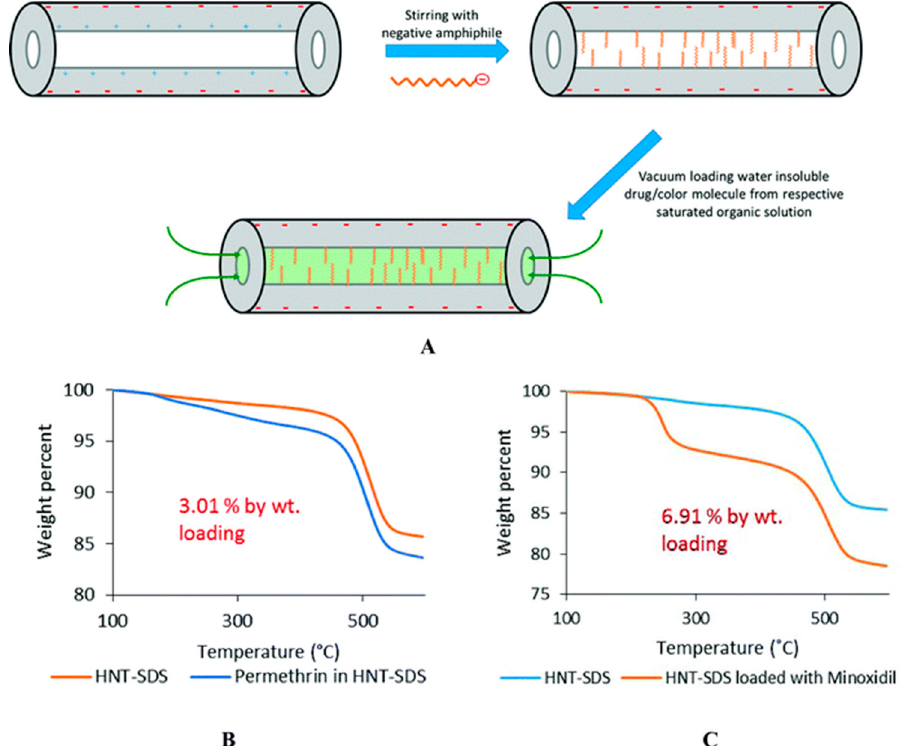
Figure 4. Illustration of sodium dodecyl sulphate (SDS) amphiphile coating inside the lumen, aiding in loading water insoluble compounds (permethrin and minoxidil) into the halloysite lumen ( A ). thermo-gravimetric (TGA) spectra of halloysites pre-treated with SDS and loaded with water insoluble active agents, permethrin ( B ) and minoxidil ( C ). Reproduced from Ref. [23] with permission from the Royal Society of Chemistry.